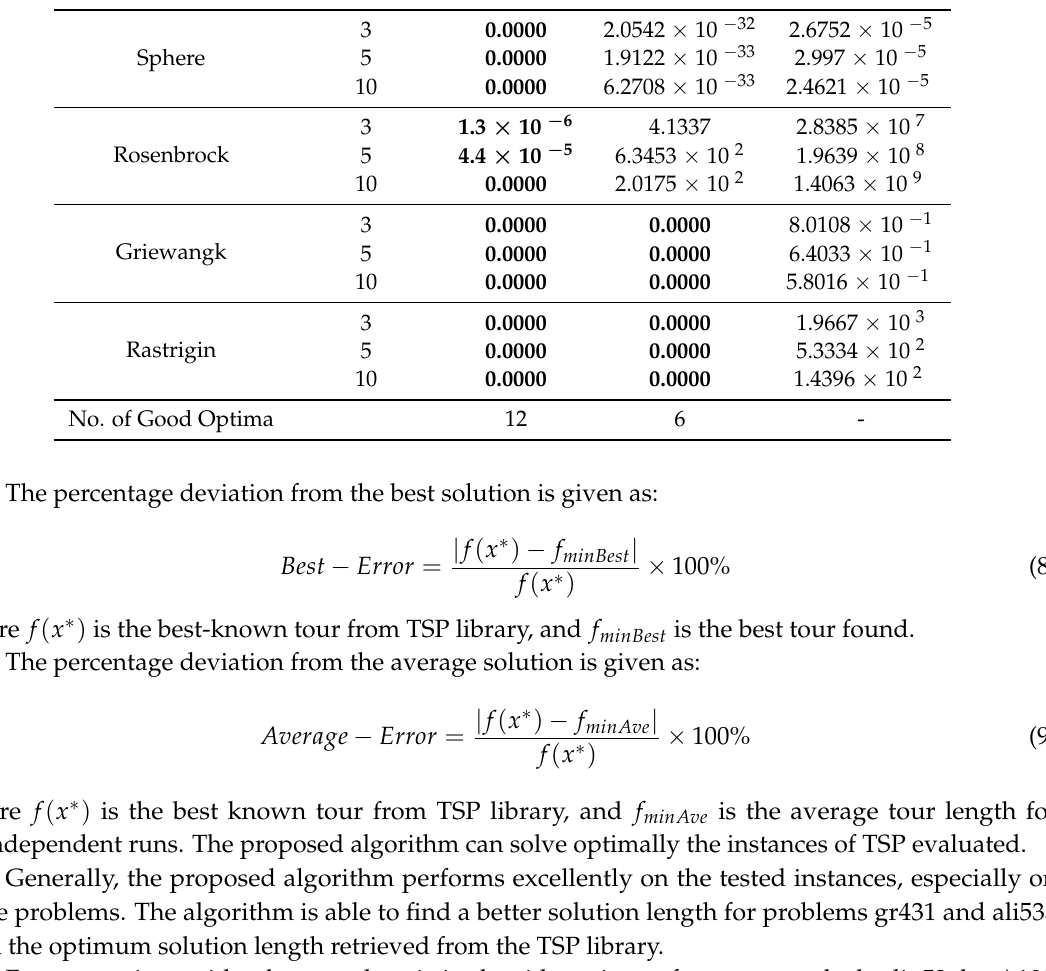
Table 8. Comparison of the mean global best of BCSO, ICSO and original CSO.